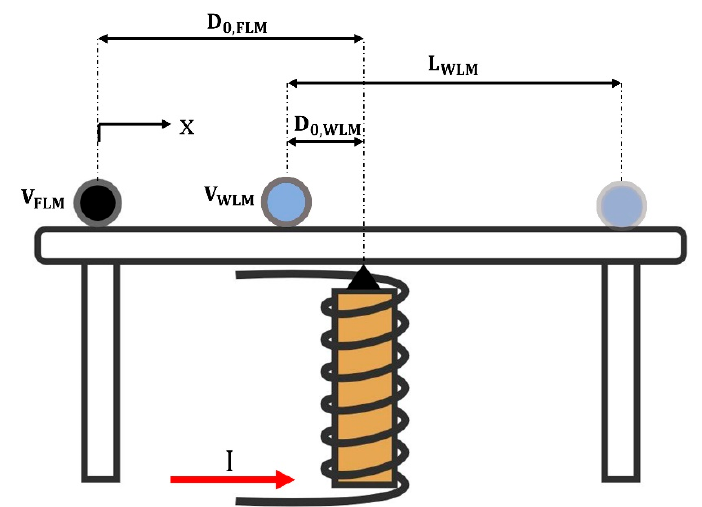
Figure 3. Schematic of the WLM shooting distance (L WLM ) in addition to five parameters in this study, including the initial distances of WLM and FLM from the electromagnet (D 0,wlm ,D 0,FLM ) , the WLM and FLM volumes (V WLM , V FLM ) , and the coil current (I). The initial position of WLM was fixed at specific distances from the electromagnet, starting from the top of the electromagnet to 2 cm away from it. Likewise, the FLM initial distance from the electromagnet decreased from 5 cm to 1 cm. Moreover, the WLM or FLM volume could be adjusted by changing the volume of water or ferrofluid droplets from 10 µ L to 50 µ L using a micropipette. The last parameter, magnetic flux density, could change by altering the current passing through the electromagnet wire from 1 A to 5